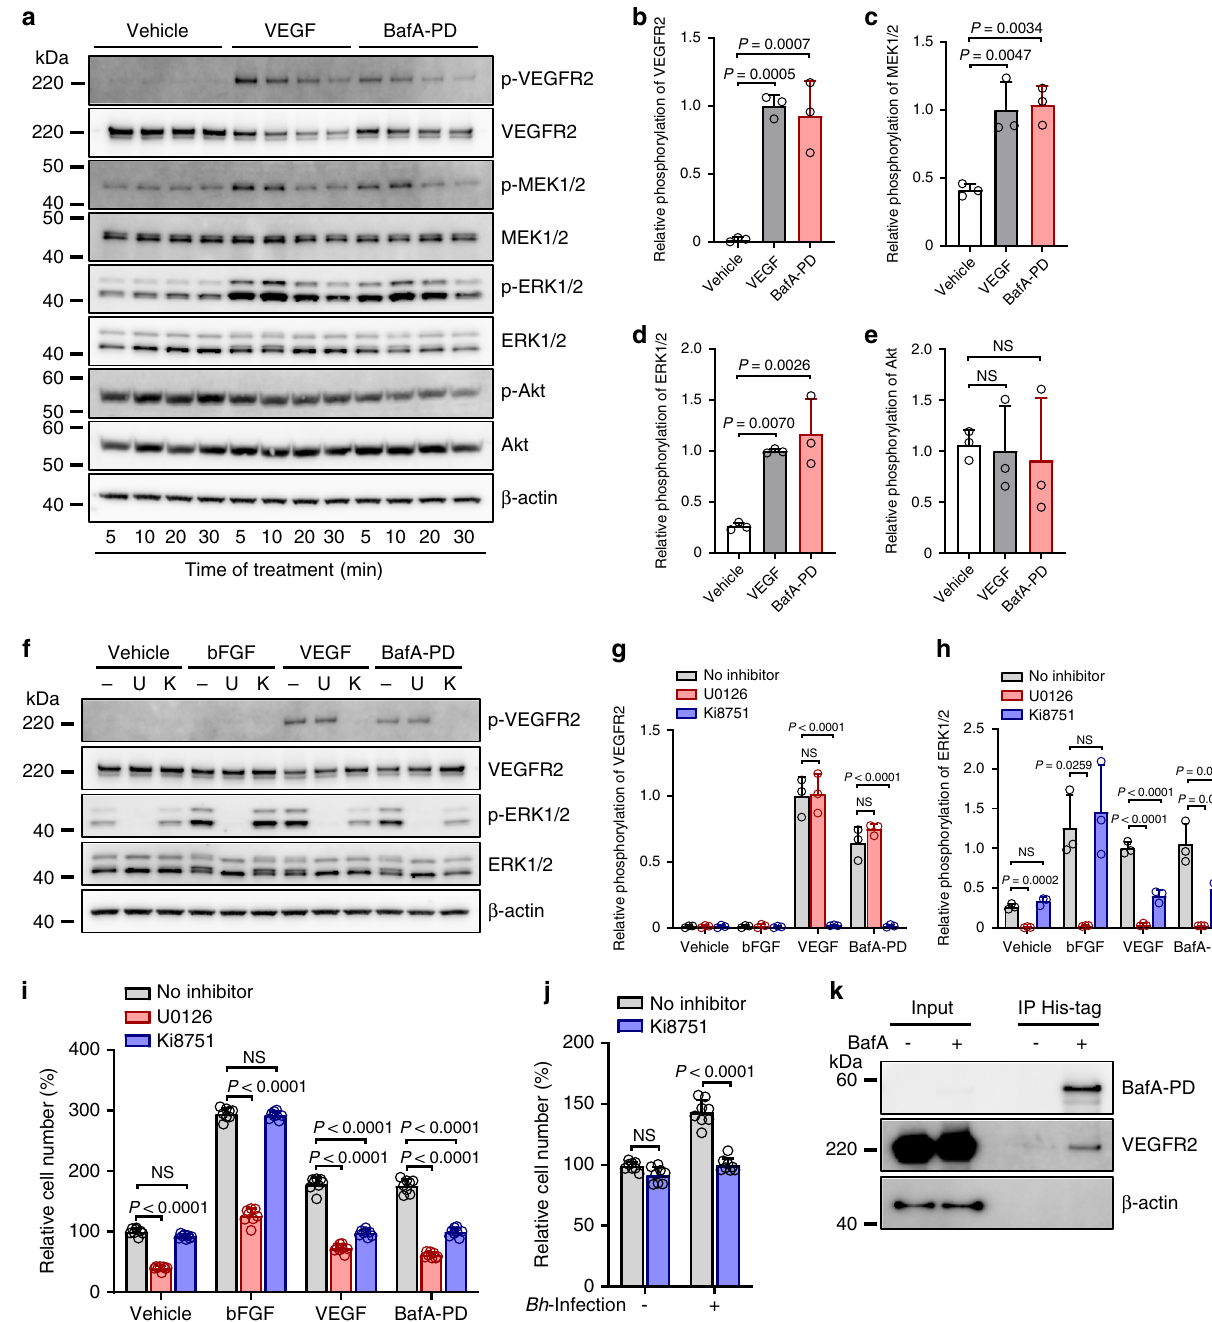
Fig. 4 BafA upregulates VEGFR2-ERK signaling pathway. a – e BafA leads to phosphorylation of VEGFR2, MEK1/2, and ERK1/2 but not Akt. HUVECs were stimulated with VEGF (20 ng/mL) or BafA-PD (100 ng/mL) for indicated time, then subjected to immunoblotting using antibody against phosphorylated (p-) or total VEGFR2, MEK1/2, ERK1/2, Akt, or β -actin ( a ). Quanti fi cation of p-VEGFR2 ( b ), p-MEK1/2 ( c ), p-ERK1/2 ( d ) and p-Akt ( e ), represented as the ratio of phosphorylated to total proteins at 10 min ( n = 3 biological replicates). Bars are colored based on the treatment: white for vehicle, gray for VEGF and red for BafA-PD ( b – e ). f – h MEK1/2 and VEGFR2 inhibitors suppress BafA-induced phosphorylation. − no inhibitor, U U0126 (MEK1/2 inhibitor), K Ki8751 (VEGFR2 inhibitor). Immunoblots ( f ), quanti fi cation of p-VEGFR2 ( g ), and p-ERK ( h ) are shown ( n = 3 biological replicates). i MEK1/2 and VEGFR2 inhibitors suppress BafA-induced cell proliferation. HUVECs were treated with each inhibitor before stimulation with bFGF, VEGF, or BafA-PD. Three days after treatment, the cell numbers were counted ( n = 8 biological replicates). j VEGFR2 inhibitor suppresses Bh -induced cell proliferation. HUVECs were treated with Ki8751 before Bh infection. Three days after infection, the cell numbers were counted ( n = 8 biological replicates). k Co-immunoprecipitation (IP) shows interaction between BafA and VEGFR2. HUVECs were treated with or without BafA-PD, then BafA-PD was immunoprecipitated with anti-His- mAb-magnetic beads. Immunoblotting was performed to detect BafA and VEGFR2. β -actin served as a loading control for inputs. Similar results were obtained in three independent experiments. Data are mean ± s.d. ( b – e , g – j ). Statistical signi fi cance was tested using one-way ANOVA with Dunnett ’ s ( b – e ) or Tukey ’ s ( g – j ) multiple comparisons test. Source data are provided as a Source Data fi